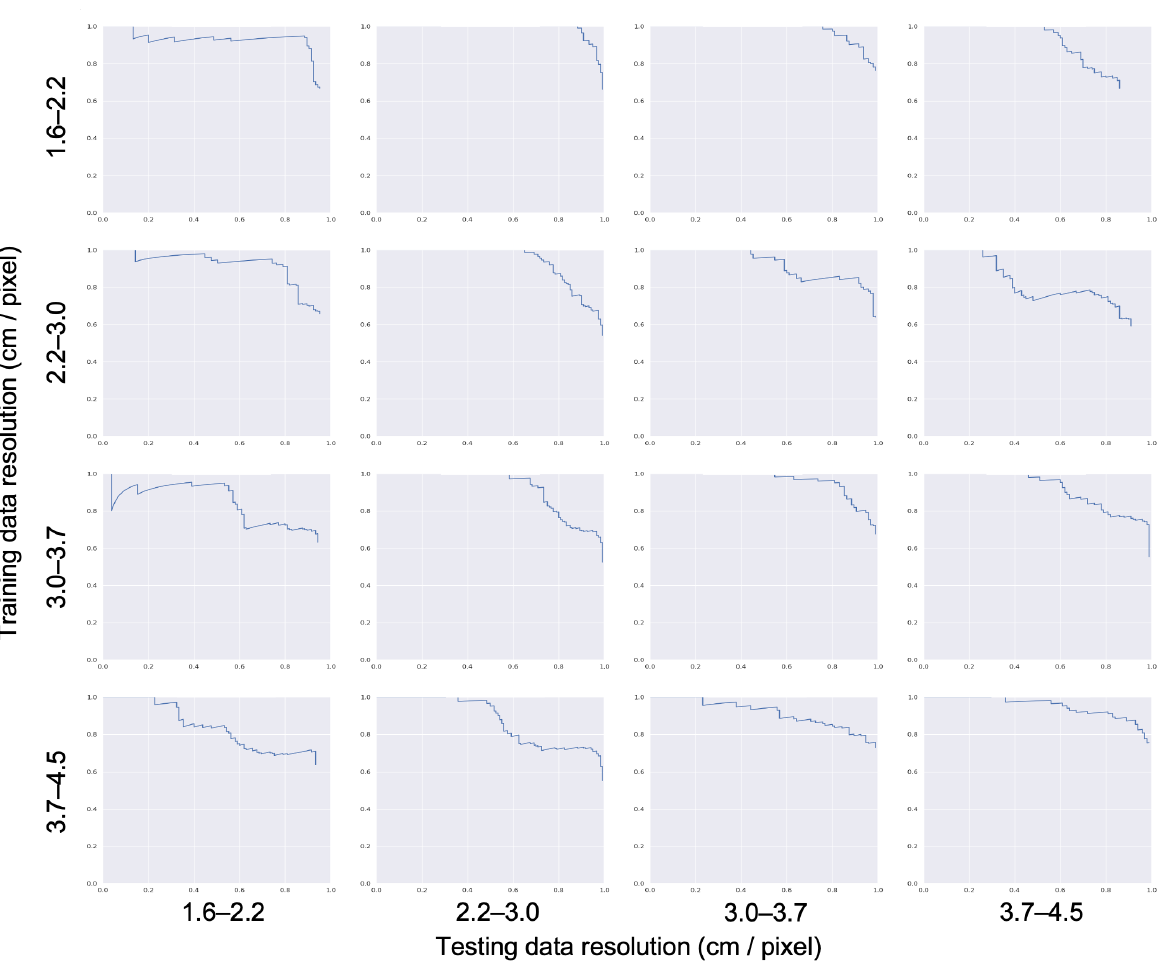
Figure A3. All precision recall curves for the summary metrics shown in Figure